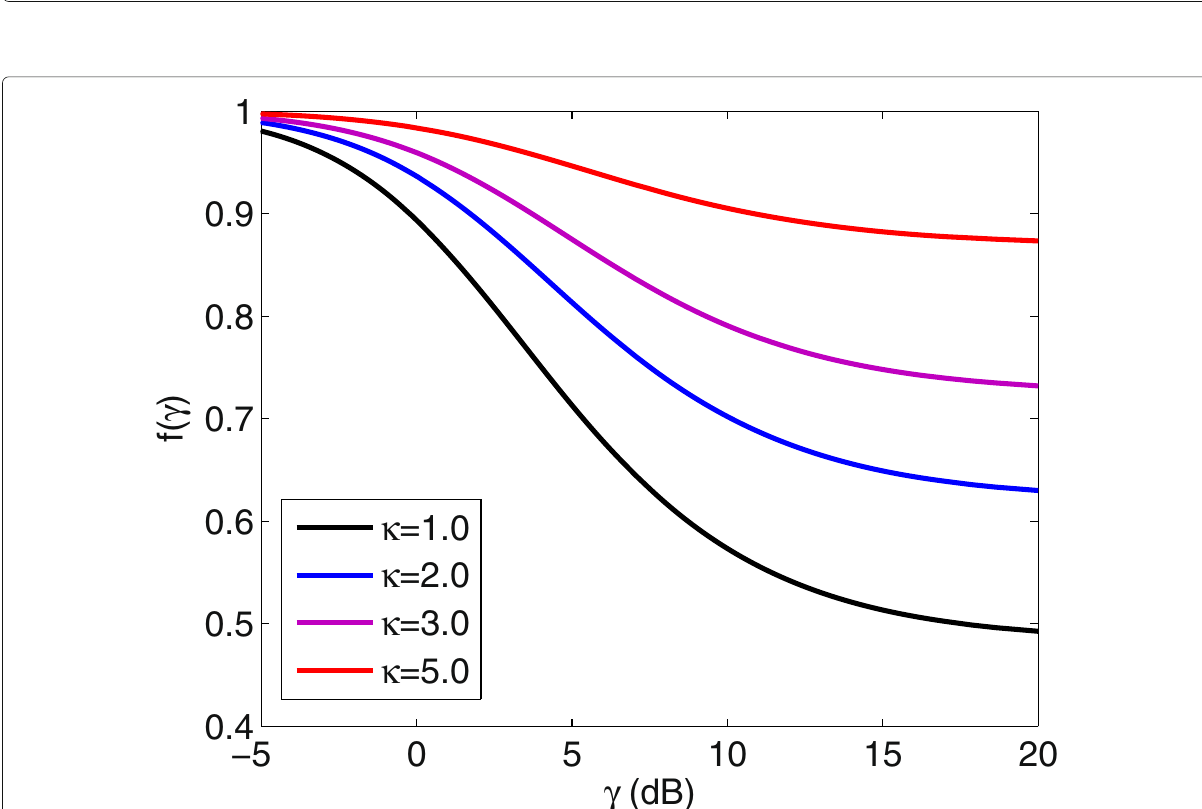
Fig. 2 Curves of the rational function f (γ) , as a function of SNR γ (dB), for fading model κ − μ with μ = 0.5 with 64-QAM modulation and different values of